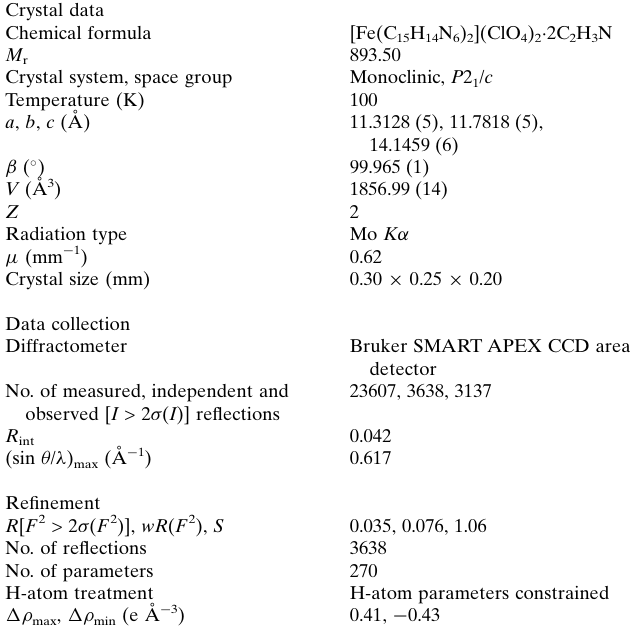
Table 2 Experimental details. Crystal data Chemical